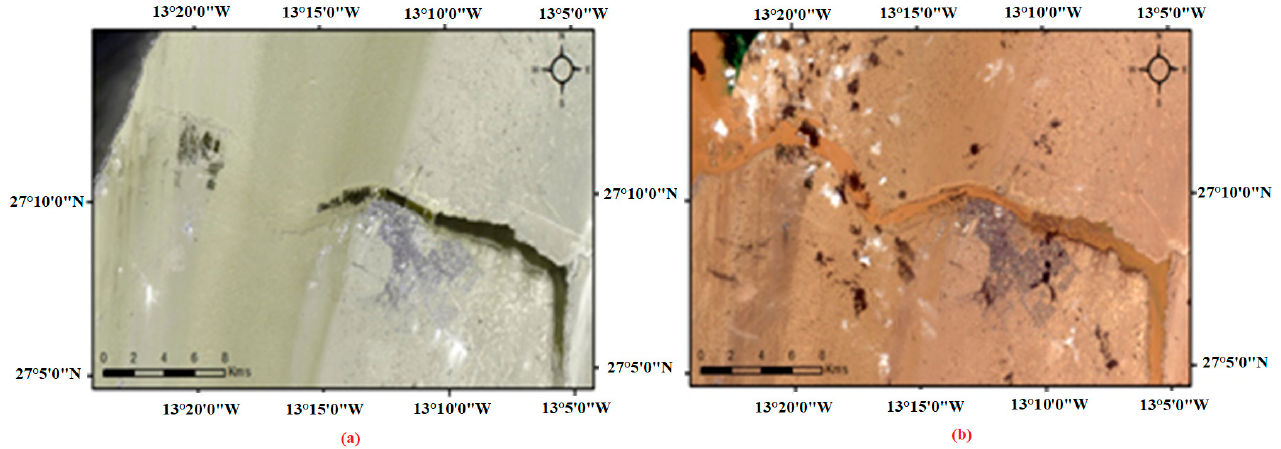
Figure 4. ( a ) Sentinel-2 RGB image (bands 2 to 4) eight days before flash flood; ( b ) Sentinel-2 RGB image (bands 2 to 4) one day after flash flood.